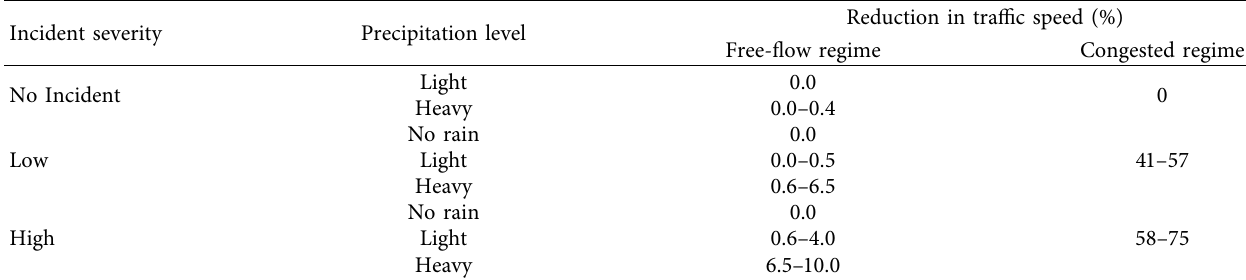
Figure 10: The Bayesian approach (a) and the resulting threshold cut-off speeds for the studied section (b). Table 3: Reduction in traffic stream speed due to precipitation and incidents in the free-flow regime and only due to incidents in the congested